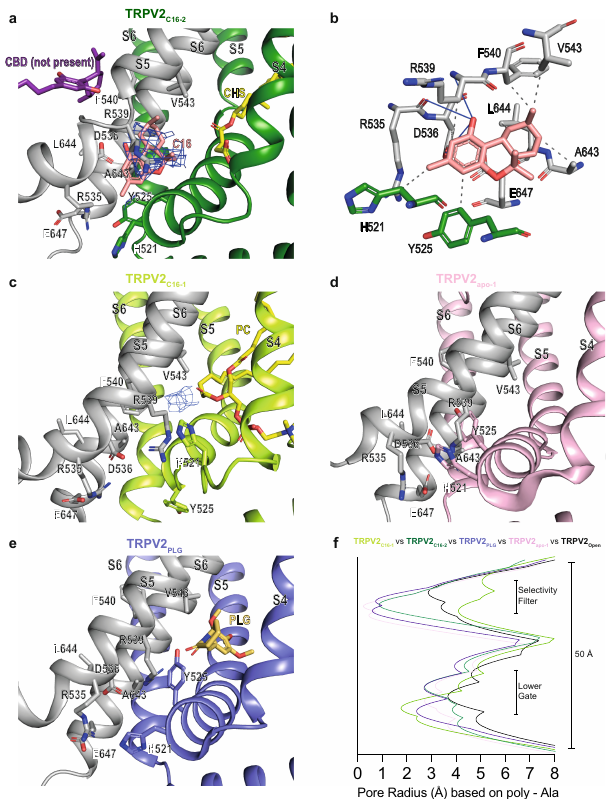
Fig. 5 | C16 binding. Proposed interaction site of C16 at the interface of two TRPV2 subunits. a TRPV2 C16-2 (dark green) and one adjacent subunit in grey with C16shownas pinksticksand thecorresponding cryo-EMdensityasblue mesh (3.0 σ ). Shown is also the binding site for cannabidiol CBD, which is distinct from the C16binding site (adapted from PDB-ID:6U8A). b The interaction networkwithC16 (pink sticks) and nearby residues in TRPV2C 16-2 . c The TRPV2 C16-1 structure (light green) also shows cryo-EM density (blue mesh at 3.0 σ level, at which protein sidechains are distinguishable) in the assigned C16 binding region of TRPV2C 16-2 , although we have left itunmodeled. CHS( a ) and PC( c ) are shown asyellow sticks. d , e The corresponding site where we observe density for C16 in our structures ( a , c ) is shown in TRPV2 apo-1 (PDB-ID: 6U84, pink) and TRPV2 PLG (PDB-ID: 6WKN, purple). PLG is shown as yellow sticks. f The pore radius in TRPV2 cryo-EM struc- tures as a function of the distance along the ion conduction pathway. TRPV2 C16-1 (light green), TRPV2 C16-2 (dark green), TRPV2 apo-1 (PDB-ID: 6U84, pink) and TRPV2 PLG (PDB-ID: 6WKN,purple).The poreradius of TRPV2 open (PDB-ID: 6BO4) is included for reference